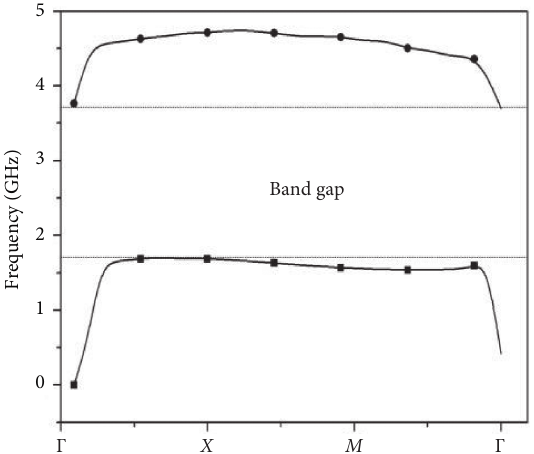
Figure 6: The simulation dispersion diagram result of ICPW-EBG unit cell.